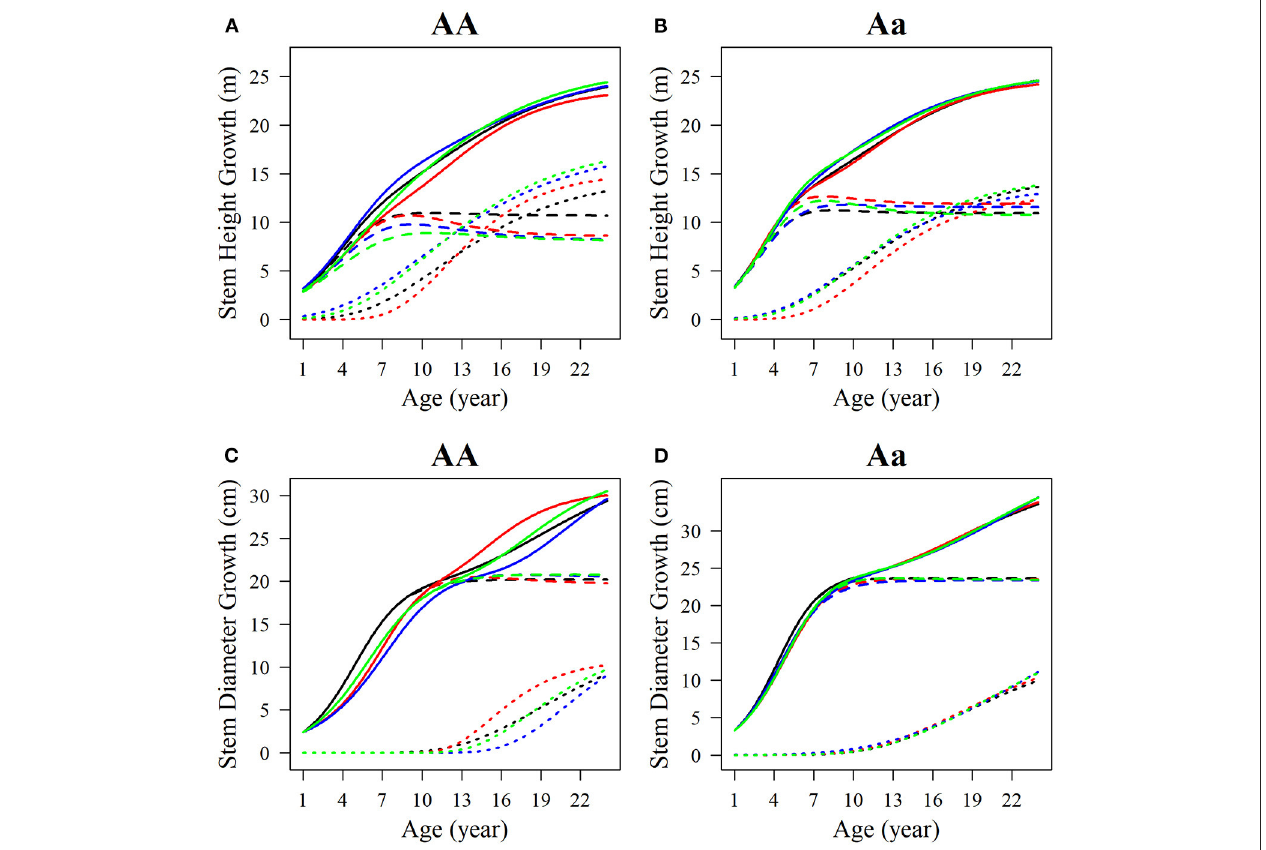
FIGURE 8 | Growth curves of stem (A, B) height and (C, D) diameter of two genotypes with a heritability of 0.05. The overall growth (solid line) for each trait is decomposed into its first phase (broken line) and second phase growth components (dotted line). The sample sizes are 66, 100, and 200. Black represents the real curve, red represents the estimation curve with the sample size of 66, blue represents the estimation curve with the sample size of 100, and the green represents the estimation curve with the sample size of 200.